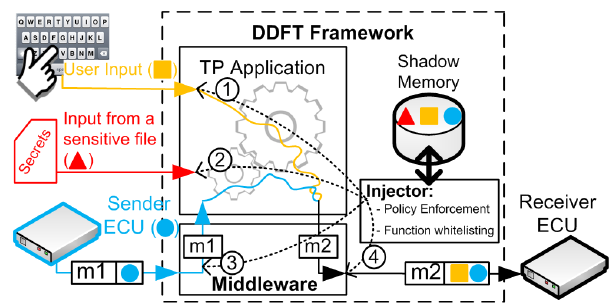
Figure 7. Overview of the DDFT framework in the on- board network. The colored shapes represent different levels of sensitivity, that are expressed by the taint values (i.e., yellow square (1), red triangle (2), blue round(3) ). These taints are injected using binary instrumentation ( Injector ). The Injector monitors the execution, especially system calls (dotted lines) and the taint propagation between memory and registers. m 1 and m 2 are tainted messages sent respectively to and from the TPA . The TPA output m 2 shows a combination of the sources “round” and “square” but not “triangle” and is therefore tainted